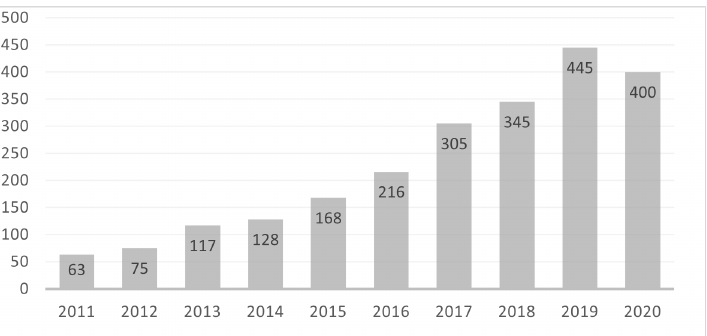
Figure 2. Number of publications on surveillance UAVs from the Web of Science Core